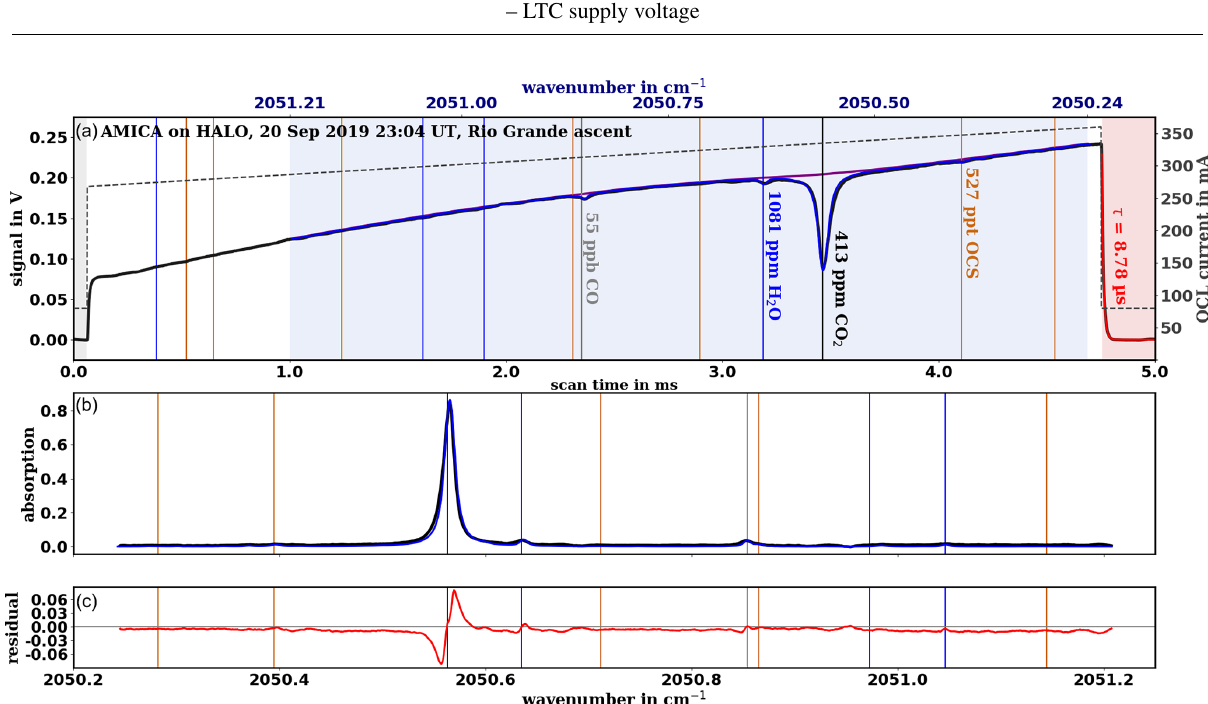
Figure 6. (a) QCL current (dashed line, right axis; the 268–360mA ramp is slightly curved to arrive at the linear wavenumber scale indicated on the top x axis) and detector voltage signal past the preamplifier (solid black line, left axis; ramps averaged over 30s) for AMICA cavity 1 in the 2050cm − 1 setup. Three periods are marked by the coloured areas – (i) grey: only detector dark signal (with zero offset) is observed; (ii) blue: period used for spectral analysis; (iii) red: period after the QCL stops emitting, when the signal decays exponentially due to “ring down” of the light in the cavity. A ring-down fit is shown by the red line. For the spectral fitting region, a measured baseline spectrum with no absorbers present (purple) and a fitted spectrum (blue) are also shown. (b) Measured and fitted spectra from (a) shown in absorption space. (c) Difference between the fit and the measured spectrum (fitted–measured). Panels (b, c) only show data for the region that is actually fitted, i.e. the blue shaded region in (a) . Absorption line positions coloured according to different gases are indicated in all panels by vertical lines for better